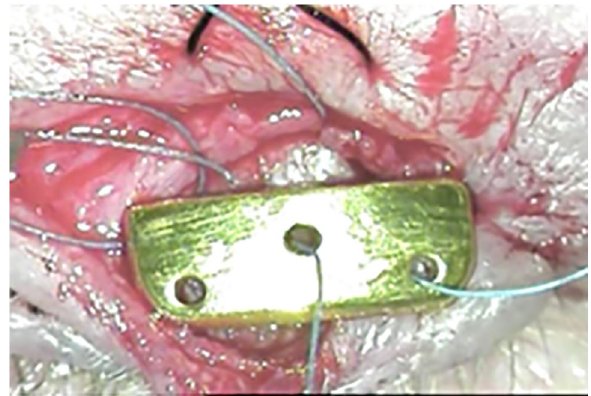
Figure 1. Typical implantation site for a gold weight.